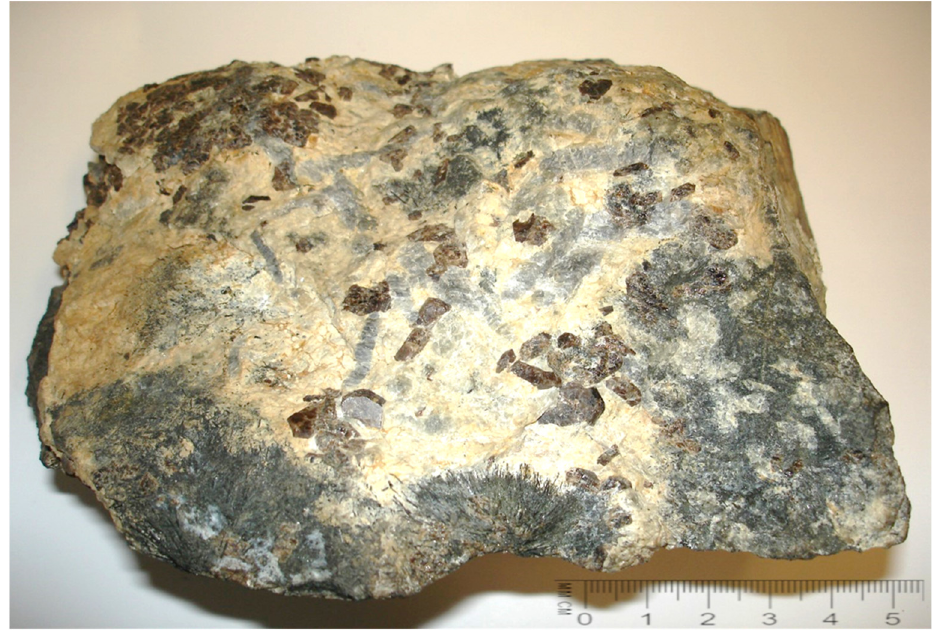
Figure 3. The sample of Odikhincha peralkaline pegmatite (17 × 14 cm). Coarse-graine part: EGM—reddish-brown, orthoclase—gray, nepheline and hydroxycancrinite mass—pale yellow, aegirine—black, fine-graine aggregates—dark-gray.